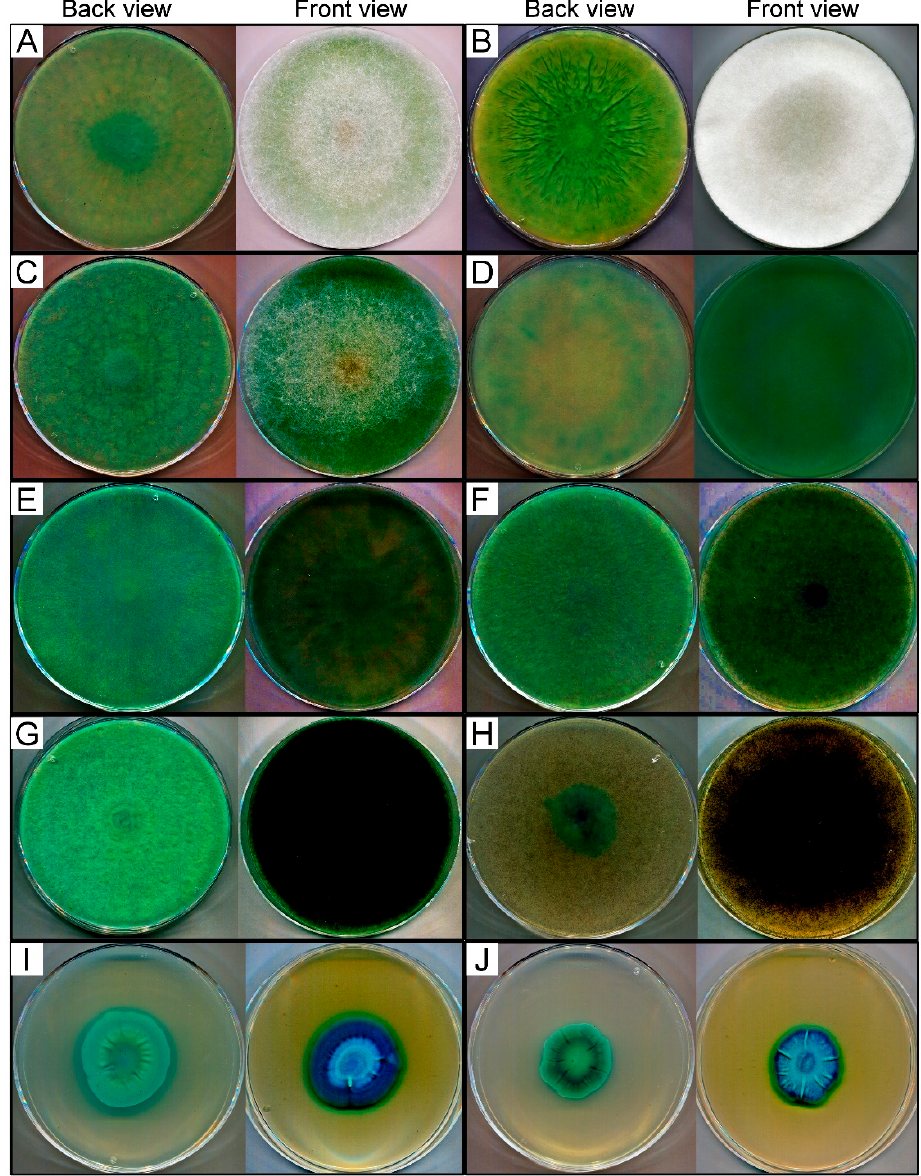
Figure 1. Colonies of L. corymbifera SZMC 11361 ( A ), L. hyalospora SZMC 11364 ( B ), L. ramosa SZMC 11360 ( C ), M. echinosphaera SZMC 11251 ( D ), R. miehei SZMC 11005 ( E ), R. miehei SZMC 11014 ( F ), R. pusillus SZMC 11025 ( G ), R. microsporus var. oligosporus SZMC 13619 ( H ), U. longicollis SZMC 11208 ( I ) and U. ramanniana var. angulispora SZMC 11234 ( J ) Mucoromycota strains grown on X-gal-containing medium. Experiments were performed on malt extract medium (20% v/v malt extract, 20 mL/L; lactose, 20 g/L; peptone, 1 g/L; agar, 20 g/L) containing 0.5% ( v/v ) X-gal solution. Data were recorded at the 10th day of cultivation.